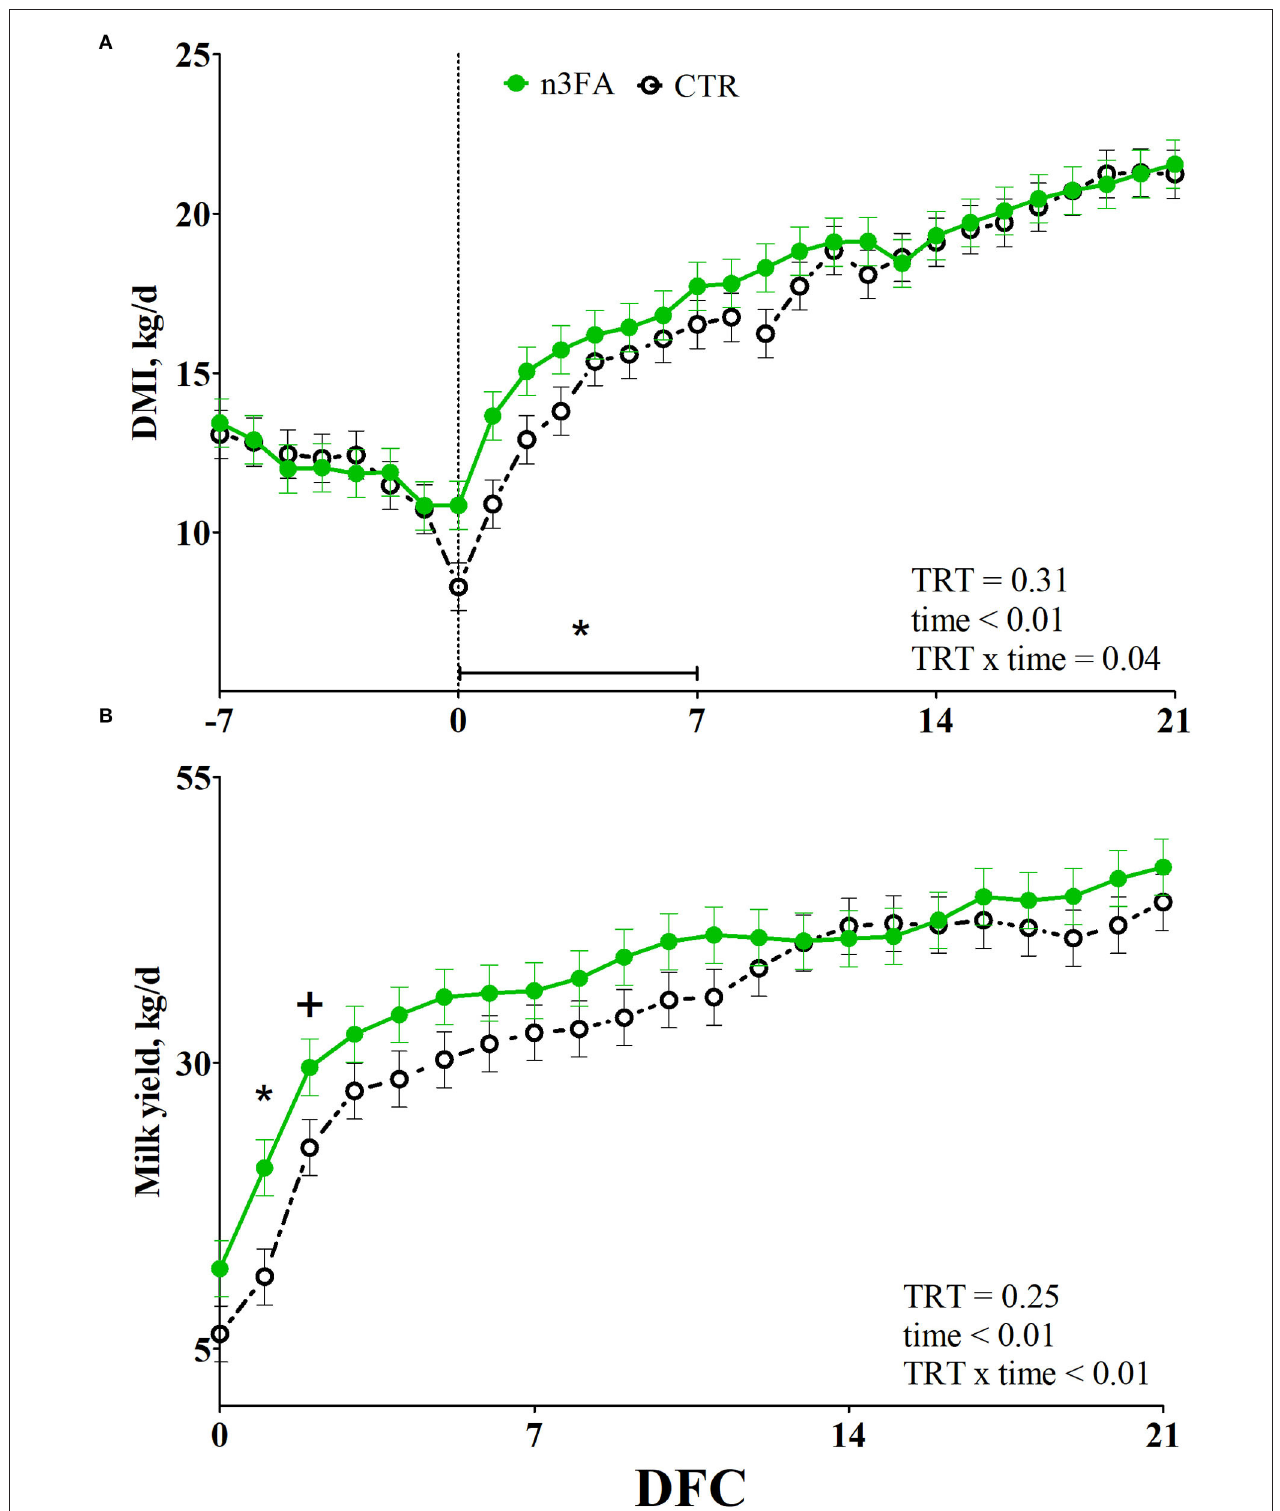
FIGURE 2 | Average week values of dry matter intake ( DMI ; A ) and daily values of milk yield (B) in dairy cows infused with 150ml of sterile saline (CTR; black dotted line) or 150ml of a 10% solution containing purified fish oil rich in long-chained omega-3 fatty acids (n3FA; solid green line) at 12, 24, and 48h after calving. TRT is treatment effect; TRT × time is treatment × time interaction effect (* is P < 0.05; + is P <